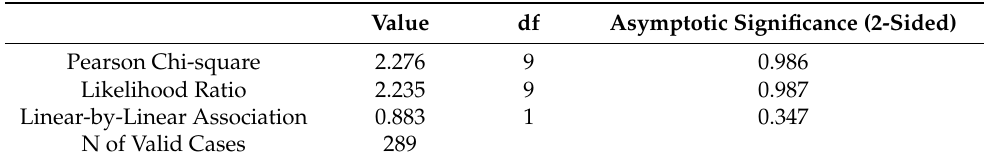
Table 9. Chi-square tests on the correlation between respondents’ experience and real-time access to information.